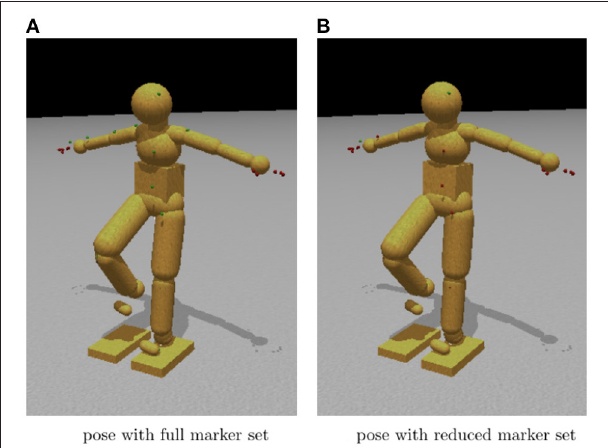
FIGURE 11 | Movement control using dynamic synergies. (A) Body configuration using all marker constraints. Note the similarity to the sparsely constrained pose. (B) Body configuration using constraints on only the head, hands, and feet. In many cases, the pose found using a full set of marker constraints is quite close to that found by a sparse set of constraints. These two images show almost no differences between using a full or a sparse set of marker